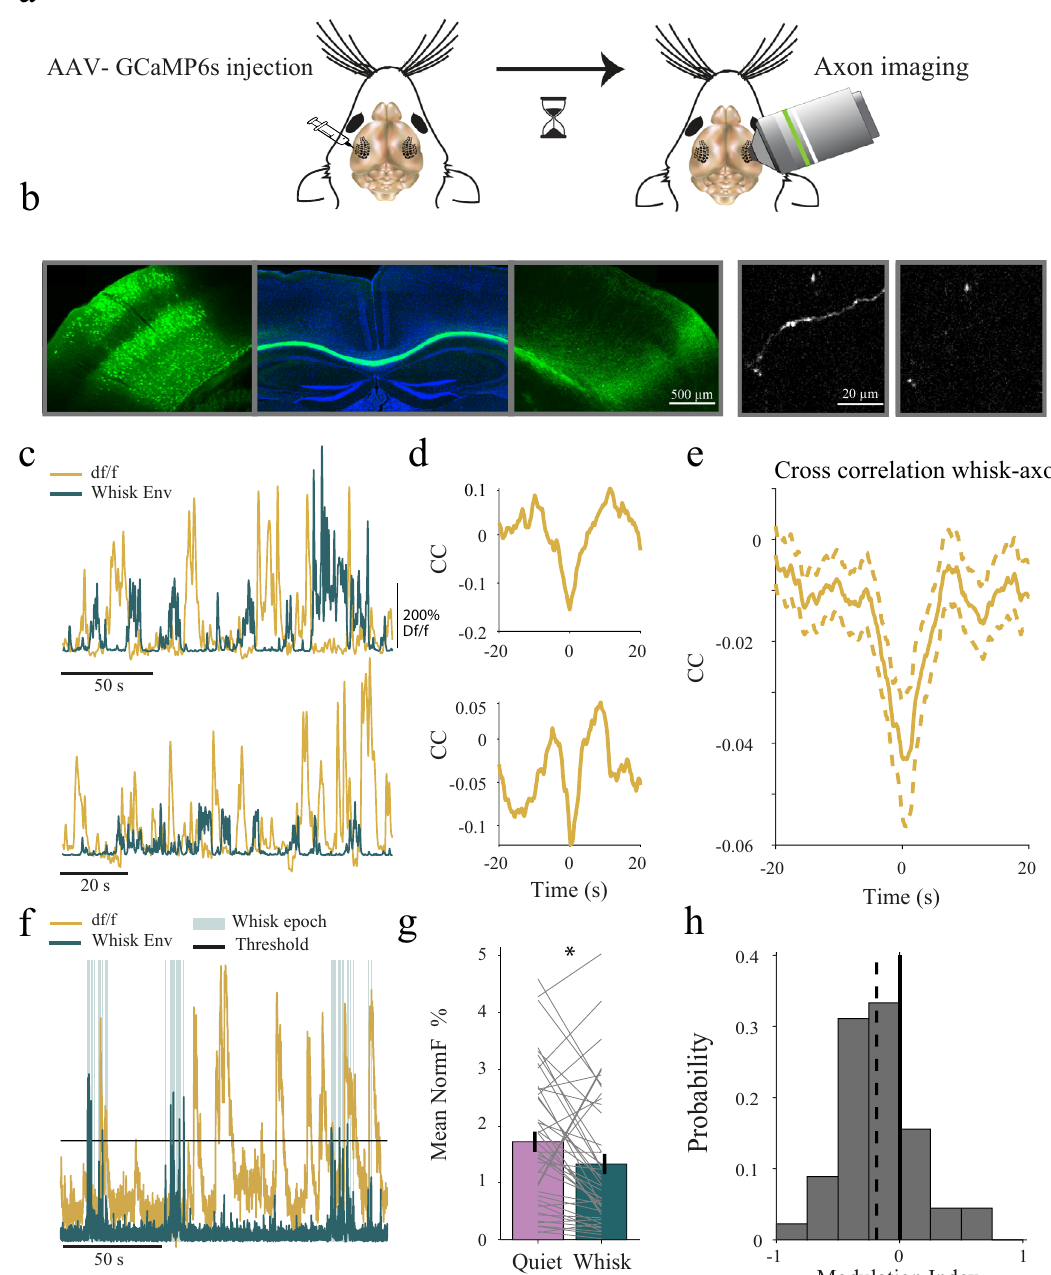
Fig. 5 Activity of callosal axons is reduced during whisking. a Schematic diagram of the injection and imaging procedures. b Histology of the injection (leftmost) and callosal projecting axons (second and third from the left), images were taken from the same slice with different exposure levels. The two right most panels show an active and non-active GCaMP6s-expressing axon (histology was performed in 3 out of 5 animals) c Two examples, from two different animals, of simultaneously recorded callosal axon calcium signals (df/f, orange) and the whisking envelope (dark green). d The cross-correlations (cc) between the callosal axon and whisking signals for the two examples in c . e Population average of the cross-correlation between callosal axon activity and whisking envelope (mean ± SEM, n = 45 axons). f An example of axonal calcium activity with a threshold demonstrating the exclusion of baseline variability. g Mean callosal axon activity (above threshold) during quiet wakefulness and whisking epochs. Each line represents the above threshold calcium signal from a single callosal projecting axon (mean ± SEM, p < 0.001, WSRT, n = 45 axons). h Histogram of the state modulation index, de fi ned as the ratio of the difference between axonal activity during whisking and quiet wakefulness divided by their sum (dashed line marks the mean, modulation index = − 0.1873, p = 0.0035, WSRT, n = 45